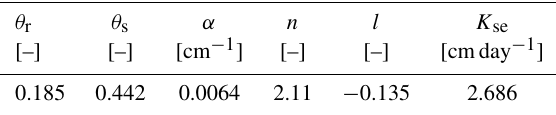
Table 1. Parameters of the van Genuchten equations used in the numerical